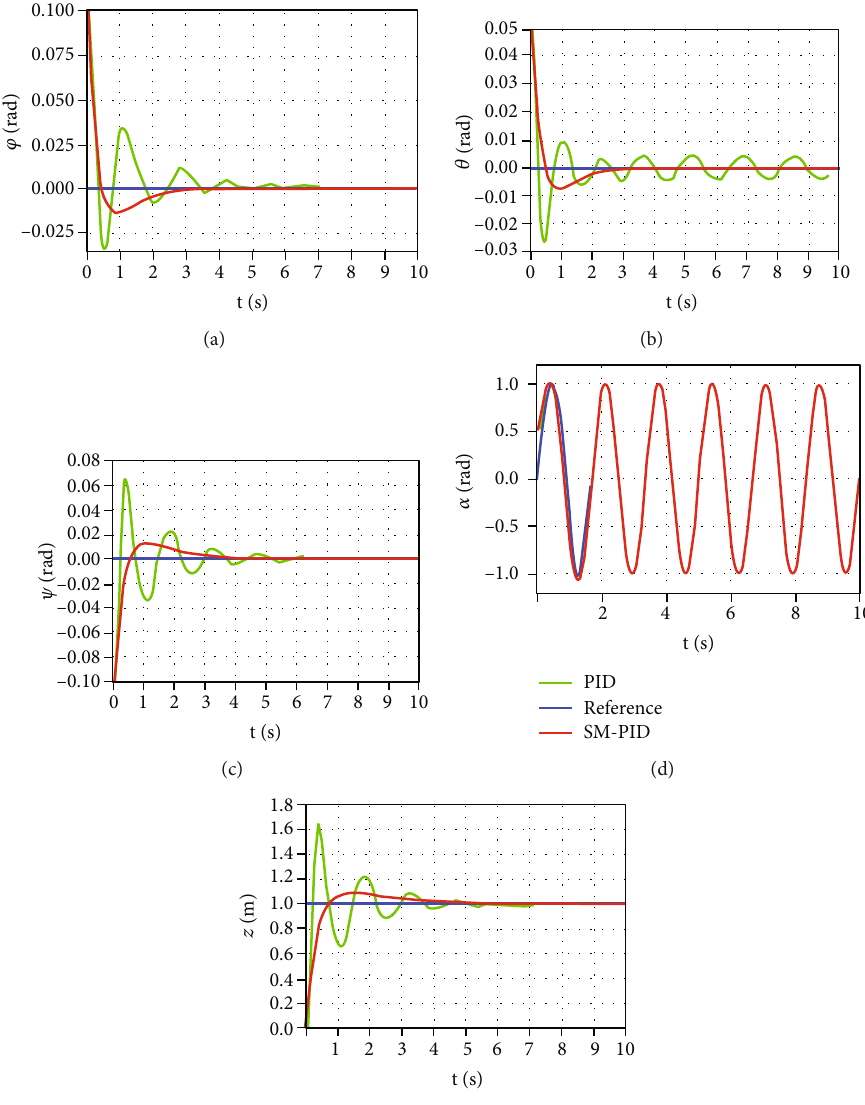
Figure 10: SM-PID control and attitude pro fi le under PID control. (a) Rolling angle. (b) Pitch angle. (c)Yaw angle. (d) Pull down tilt angle. (e)Altitude